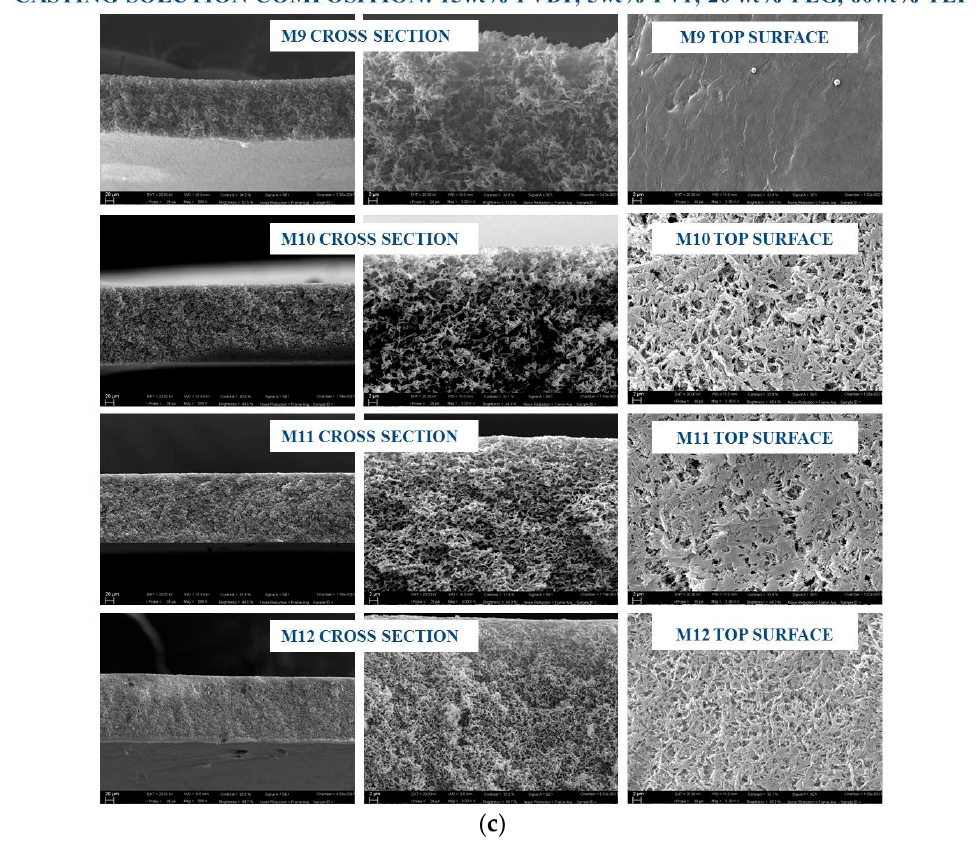
Figure 2. ( a ) Casting solution composition 15 wt % PVDF, 5 wt % PVP, 10 wt % PEG, 70 wt % TEP; ( b ) Casting solution composition 15 wt % PVDF, 5 wt % PVP, 15 wt % PEG, 65 wt % TEP; ( c ) Casting solution composition 15 wt % PVDF, 5 wt % PVP, 20 wt % PEG, 60 wt % TEP.